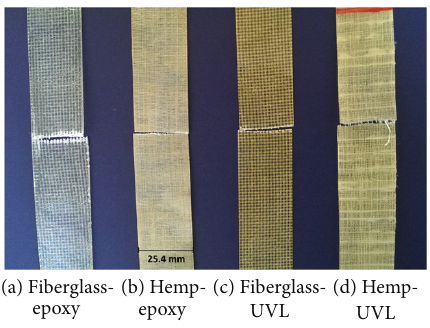
Figure 7: Tension failure behaviors of epoxy and UVL composites with B-APTES-coated